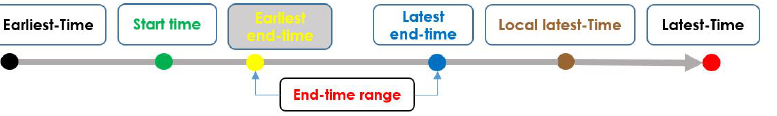
Figure 17. End-time range-global view: both end-time range bounds are located between the start- time and the latest-time.